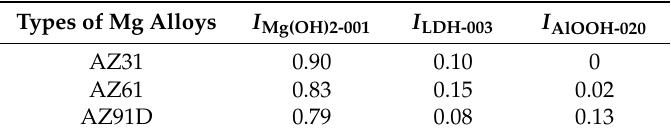
Table 1. Peak intensity ratio of 011 reflection of Mg(OH) 2 , I Mg(OH)2-001 , 003 reflection of Mg-Al